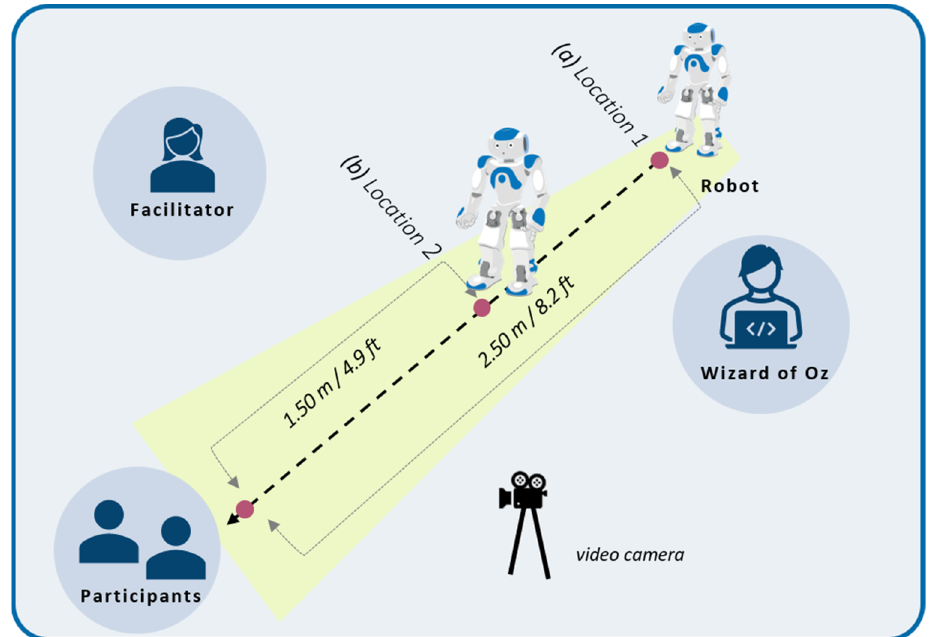
Figure 2. Setting of the experimentation indicating ( a ) the initial location of the robot at the start of the scenario, then its final location ( b ) where it performs the presentation of the precautionary measures.